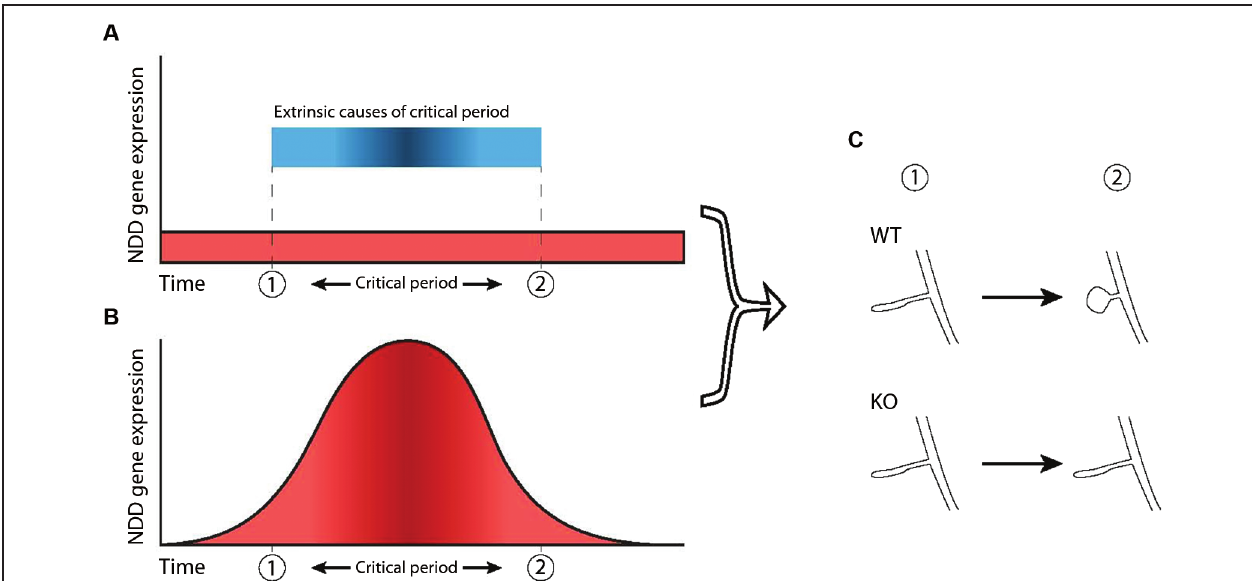
outcome of the critical period. Hence, dysfunction of the gene leads to an impaired critical period. (B) Increased NDD gene expression (red area) directly regulates the critical period and causes it to occur, independent of external factors. Therefore, dysfunction of the NDD gene causes the critical period to be absent completely. (C) In both scenarios, the NDD gene is necessary for the phenotypic change that takes place during the critical period (“WT” vs “KO”), represented here by maturation of spine